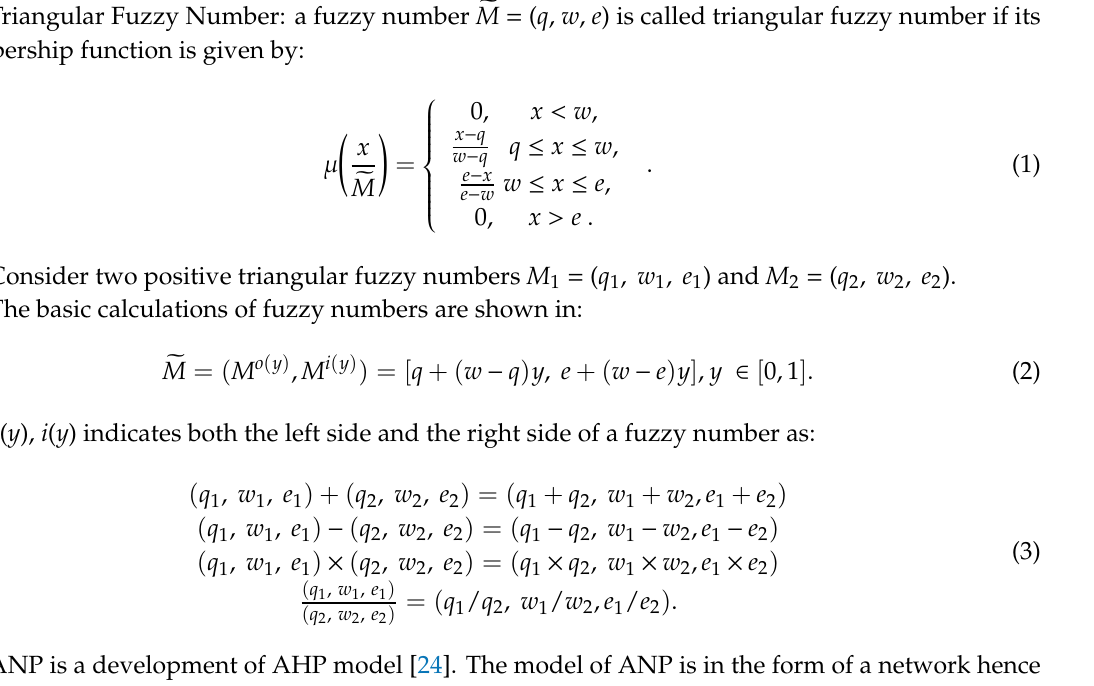
Figure 2. Triangular Fuzzy Number.